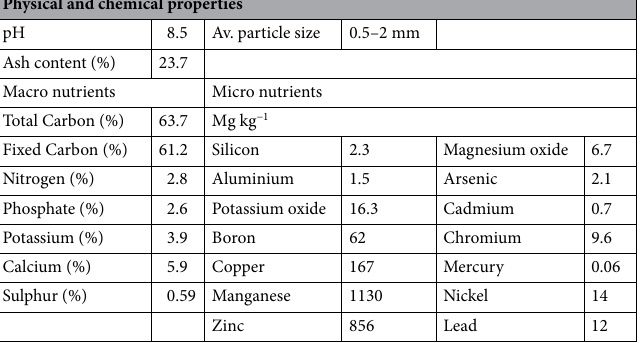
Table 4. Selected physical and chemical properties of chicken litter biochar. Source : BlackEarth Company in north of Bendigo Victoria,